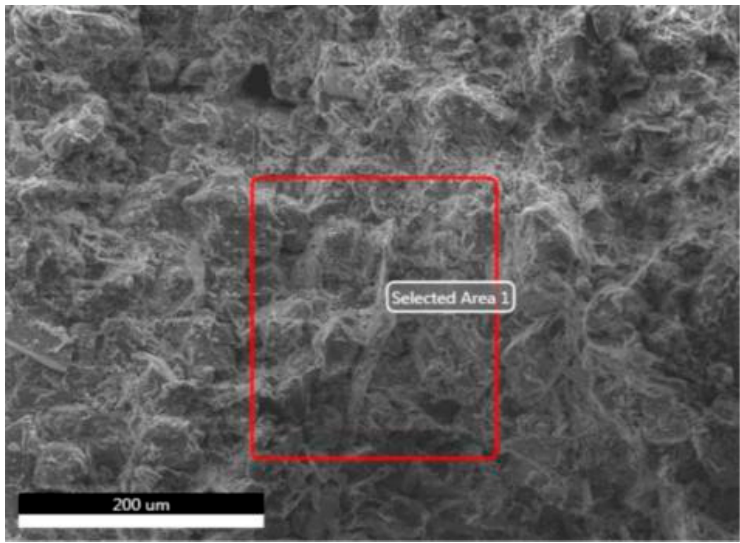
Figure 12. D-3 selection of energy spectrum region of soil sample. Table 6 and Figures 13–15 are energy spectrum analysis charts of soil samples A-0, D-0 and D-3, respectively. Table 6. A-0 element content in energy spectrum area of soil sample. Element